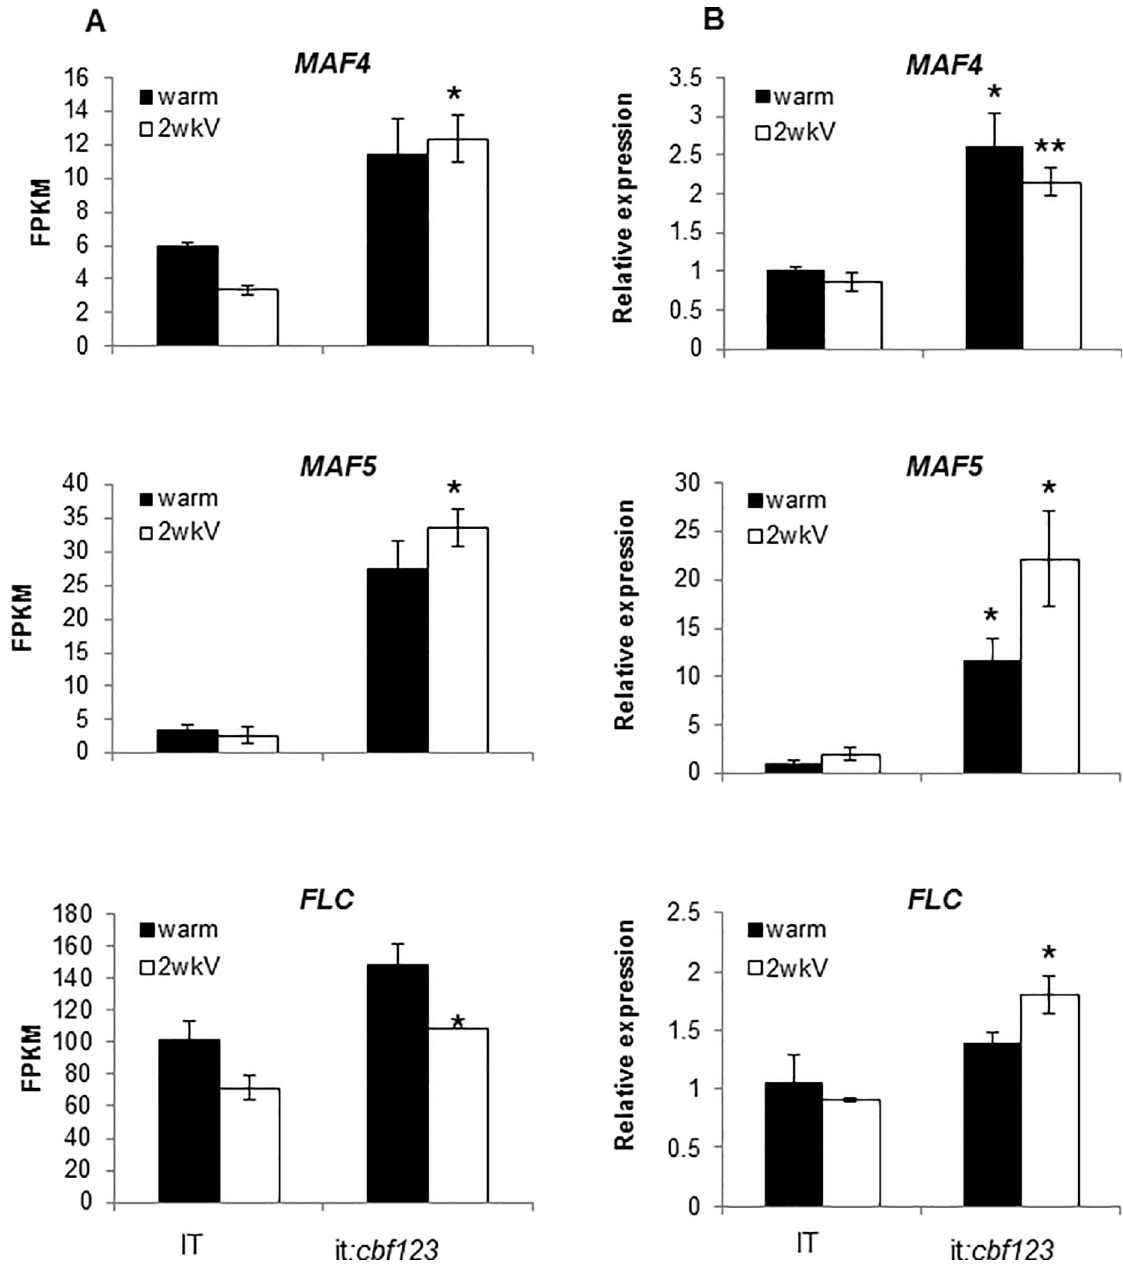
Fig 9. Expression of flowering repression genes MAF5 , MAF4 and FLC were higher in it: cbf123 plants than in IT plants. Expression levels of MAF4 , MAF5 , and FLC were determined either by RNAseq (A) or by quantitative RT-PCR (B) in IT and it: cbf123 plants grown at 22˚C (warm) or at 22˚C followed by 2 weeks at 4˚C (2wkV) under a 16-h photoperiod. Error bars indicate SE of two (A) or three (B) biological replicates. FPKM = Fragments Per Kilobase of transcript per Million mapped reads. Asterisks indicate a significant difference in expression level between IT and it: cbf123 plants (Student t-test, � indicates P < 0.05, �� indicates P <